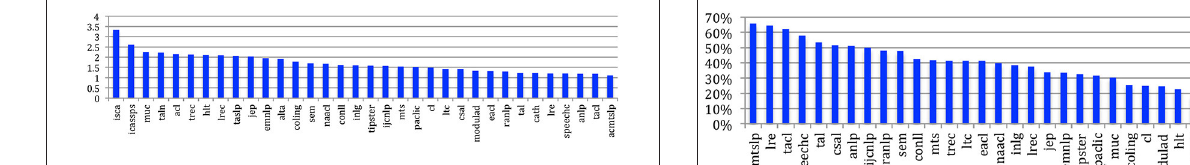
FIGURE 18 | Average number of papers published by each different author across the sources.